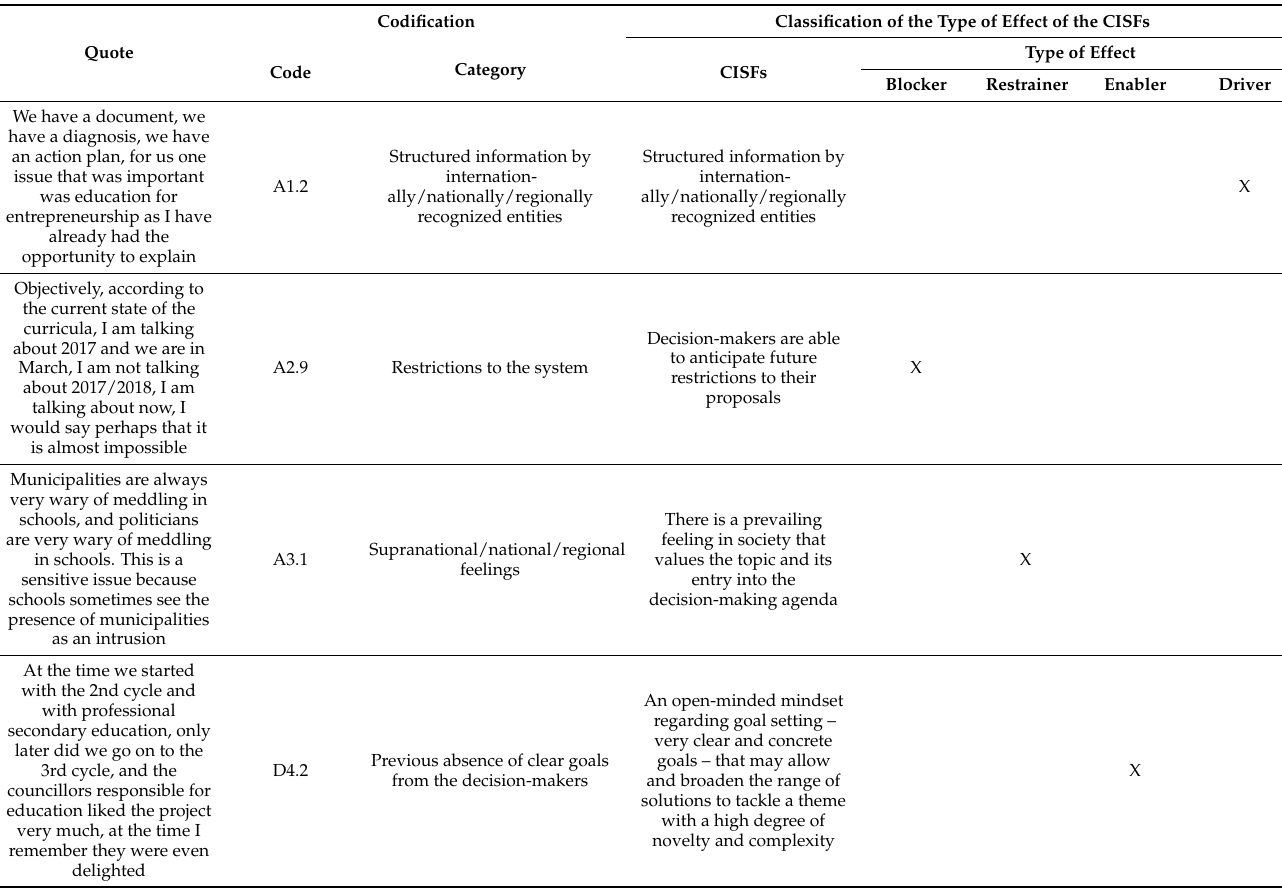
Table 3. Four Examples of the Process of Codification and